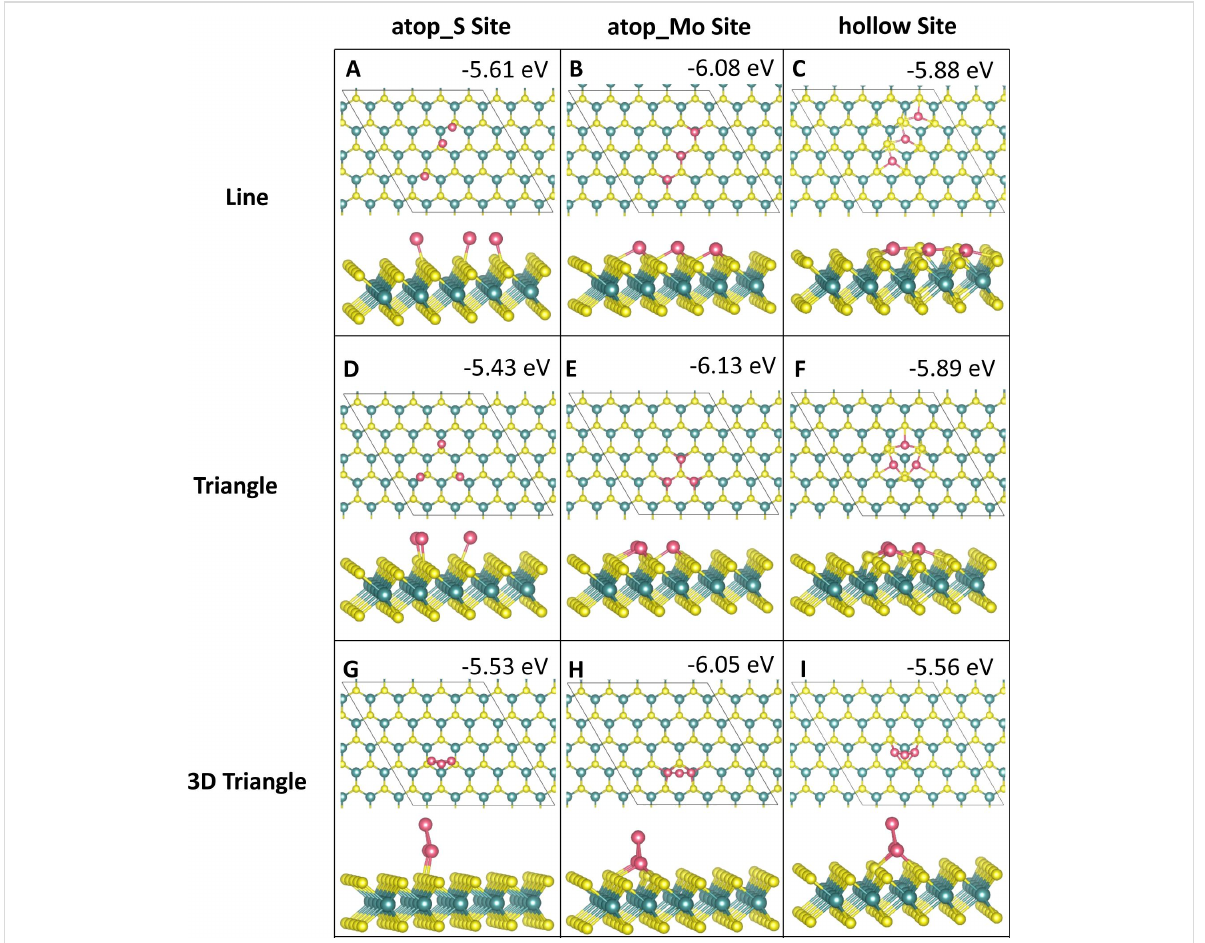
Figure 5: Atomic structure and energies of Co 3 adsorption modes on perfect MoS 2 .